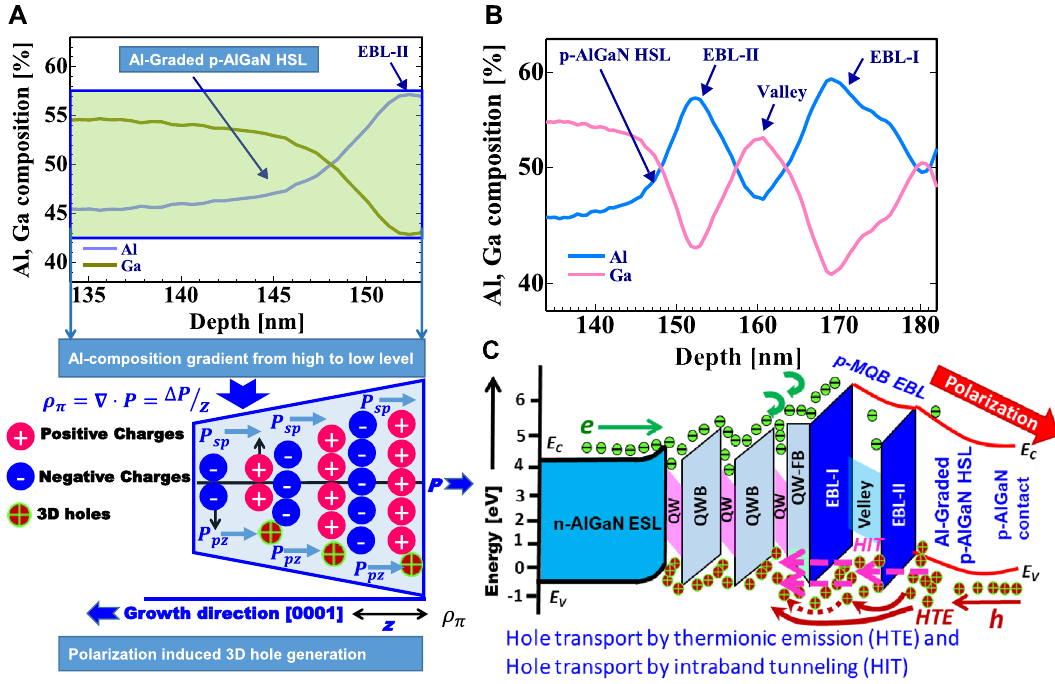
Figure 1. SIMS spectra of Al and Ga composition in ( a ) Al-graded p-Al 0.58 Ga 0.42 N p-AlGaN hole source layer (HSL) (Inset: Schematic illustration of polarisation induced 3D hole generation in the Al-graded p-AlGaN HSL structure, and bandgap diagram of the graded layer, where negative polarisation charge field created by an inclination of Al-profile in Mg-doped p-AlGaN HSL), ( b ). SIMS spectra of Al and Ga composition in Mg-doped p-MQB EBL including p-AlGaN HSL, and ( c ). Estimated energy-band diagram of the newly designed p-AlGaN- based ultraviolet-B light-emitting diode